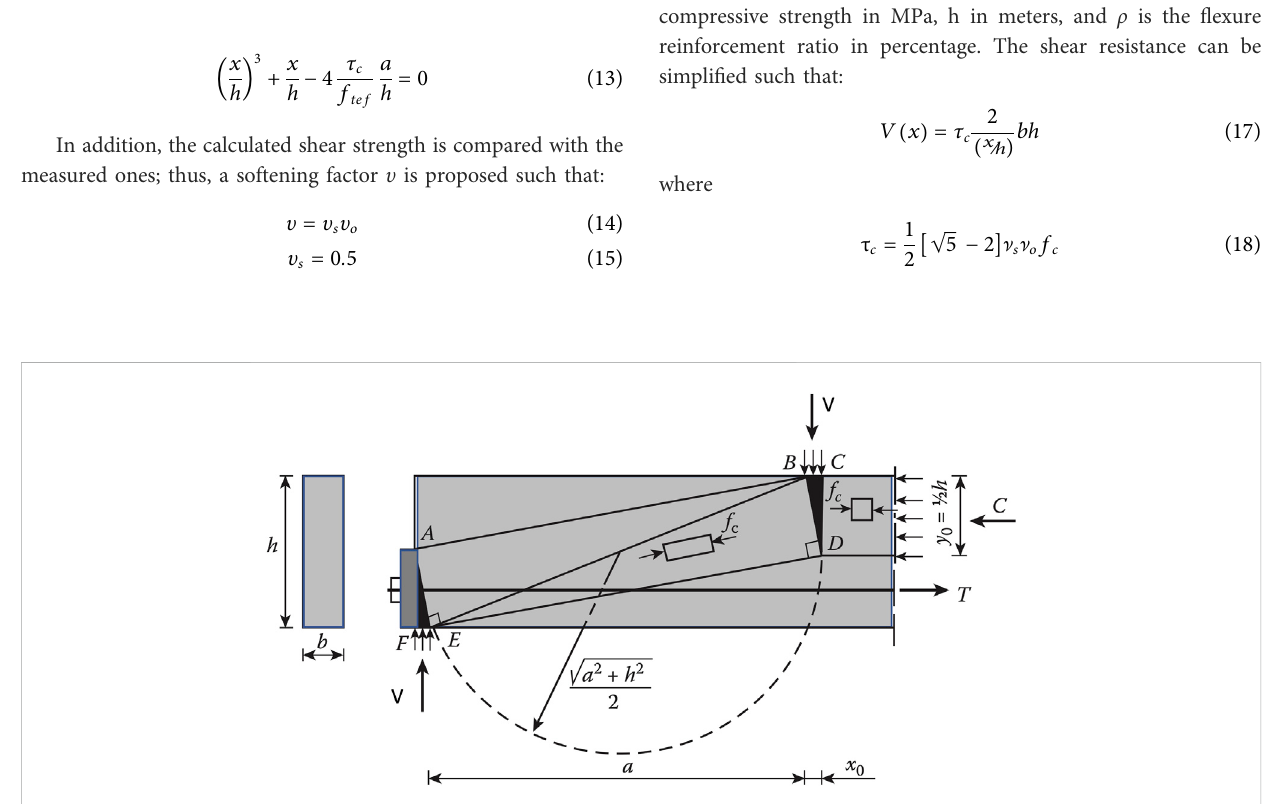
FIGURE 6 Upper bound solution of four-point loading beam.